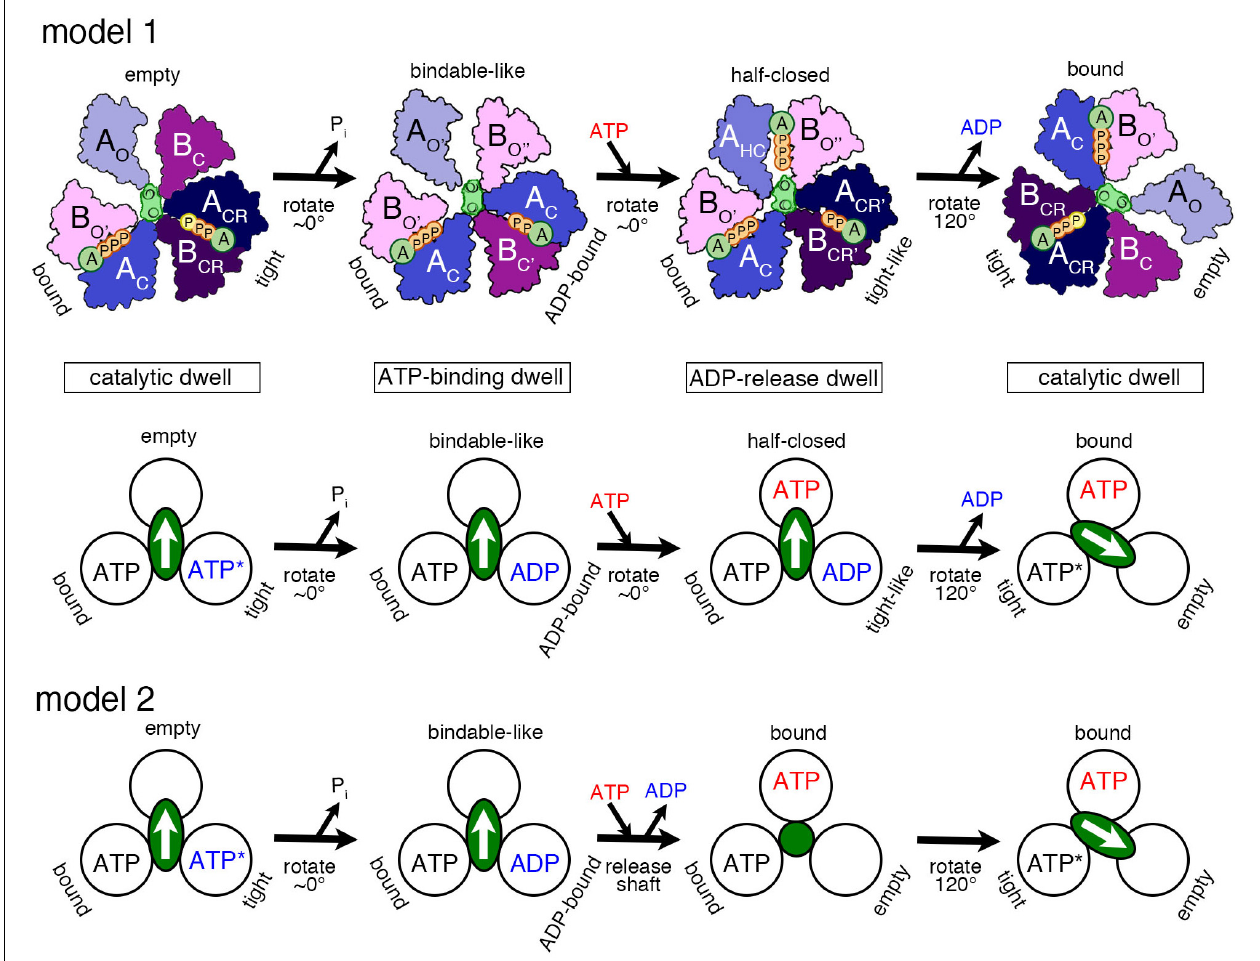
FIGURE 3 | Proposed models of the rotation mechanism of Enterococcus hirae V 1 -ATPase based on the crystal structures. [Model 1 (Suzuki et al., 2016)] Upper drawings show the structural models from the left to the right panel based on the crystal structures of 2 ATP V 1 (catalytic dwell), 2 ADP V 1 (ATP-binding dwell), 3 ADP V 1 (ADP-release dwell), and 2 ATP V 1 . ATP indicated with a yellow ‘P’ in 2 ATP V 1 represents an ATP molecule that is committed to hydrolysis. Lower drawing shows the coupling model of the 120 ◦ rotation of the shaft (green ellipse with white arrow) and the ATP hydrolysis based on the structural model (upper drawings). Each circle represents the conformation of the nucleotide-binding site, viewed from the cytoplasmic side. The orientation of the shaft begins from the 12 o’clock position in the catalytic dwell waiting for ATP hydrolysis. ATP ∗ represents an ATP molecule that is committed to hydrolysis. ATP ∗ is hydrolyzed to produce ADP and Pi, and the Pi release induces the conformational changes to the ATP-binding dwell state, without a rotational sub-step. ATP binding at the ‘bindable-like’ form in the ATP-binding dwell state, induces the conformational changes to the ADP-release dwell, without an apparent rotational sub-step. ADP release from the ‘tight-like’ form induces the dissociation of the shaft, thermal 120 ◦ rotation, and consequent conformational changes to the catalytic dwell. [Model 2] An alternative coupling scheme of the model 1 without the ADP-release dwell state is shown. ATP binding to the ATP-binding dwell state induces the concomitant release of the shaft and ADP. Therefore, this transient intermediate structure may correspond to that of 2 ATP A 3 B 3 with the shaft (green circle) thermally fluctuating. For details, see text.